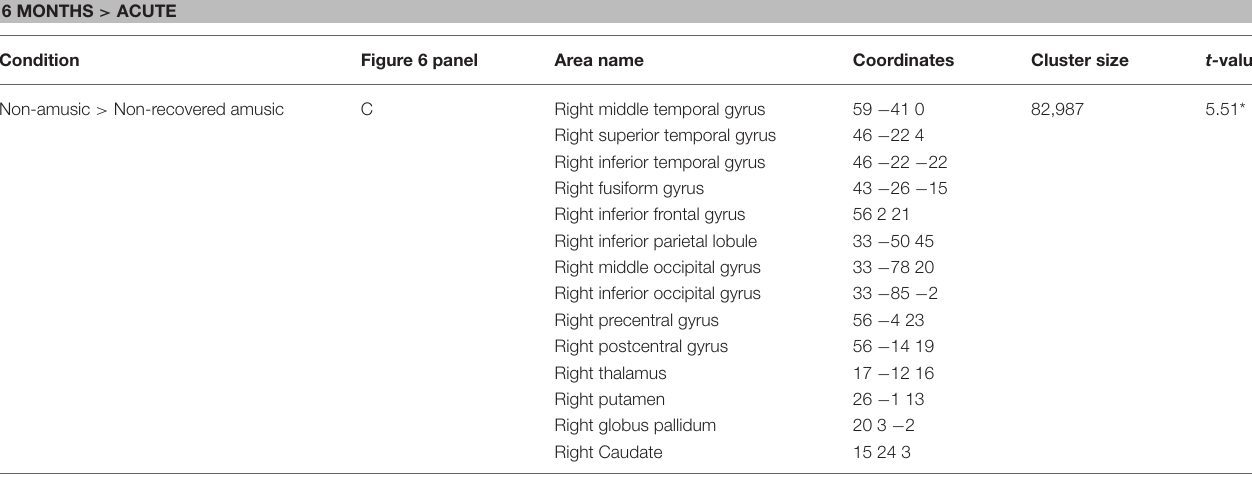
TABLE 5 | White matter volume decreases (6-month stage—acute stage) in pitch amusia: pooled analysis.